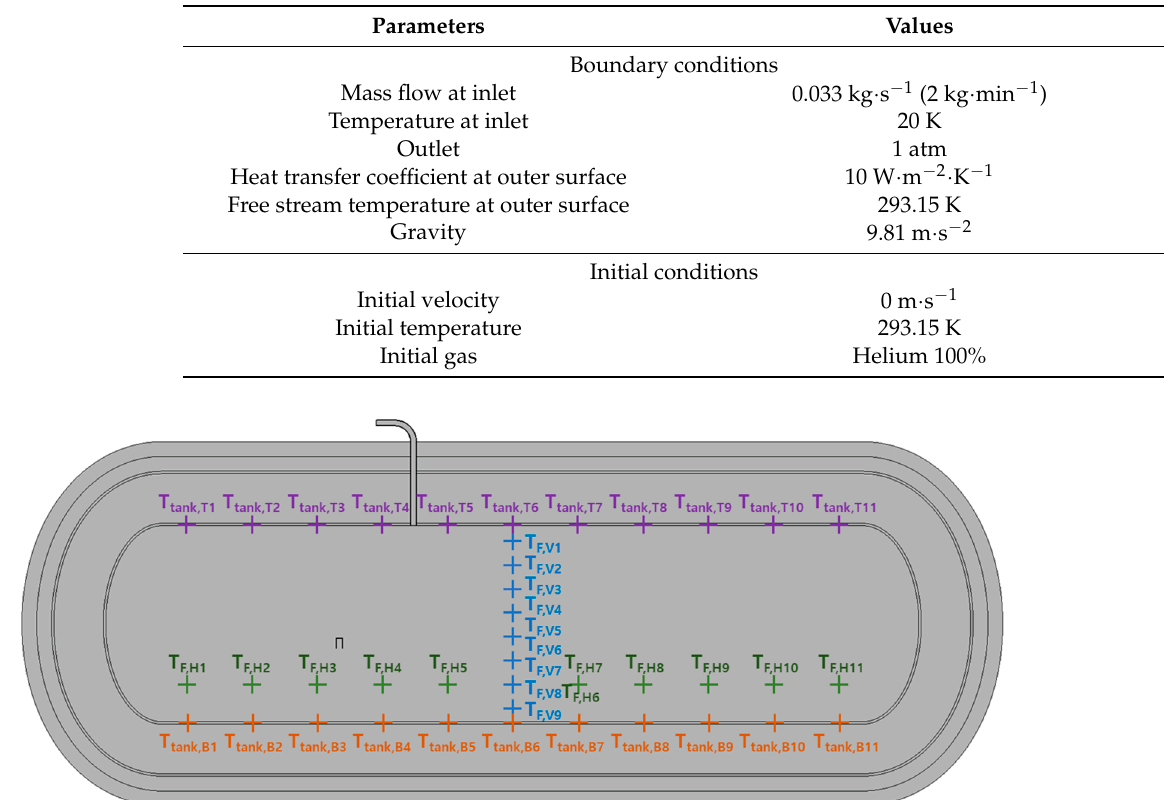
Table 3. Boundary and initial conditions.